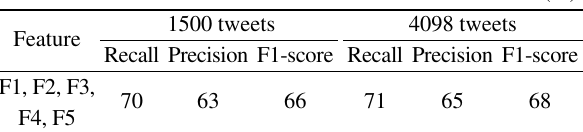
Table 9 All features for detecting the earthquake event in linear kernel.